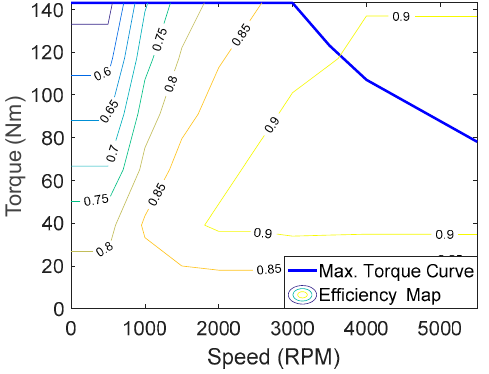
Figure 5. Efficiency map of the generator.